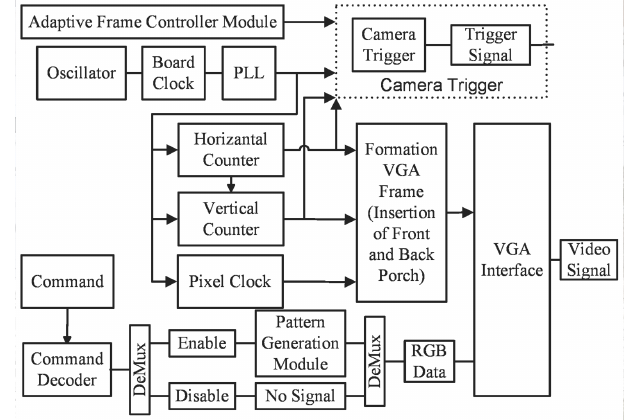
Figure 13. Block diagram of VGA controller and camera trigger